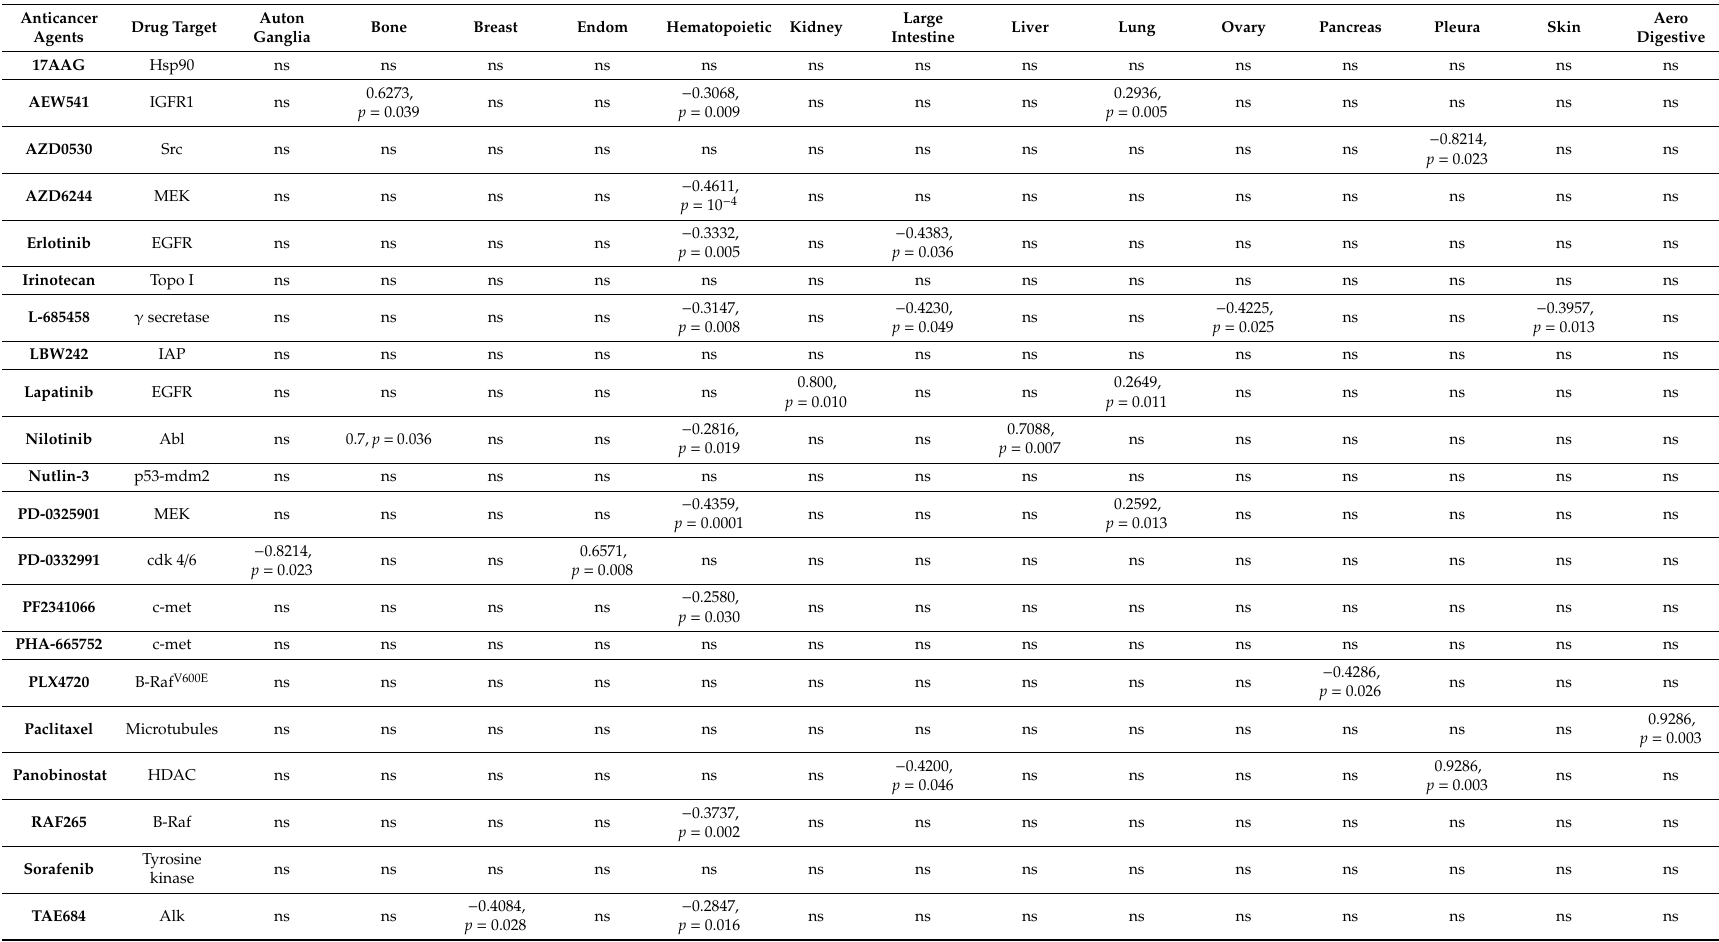
Table 2. Correlations between RND1 expression and sensitivity to anticancer agents in several tumor